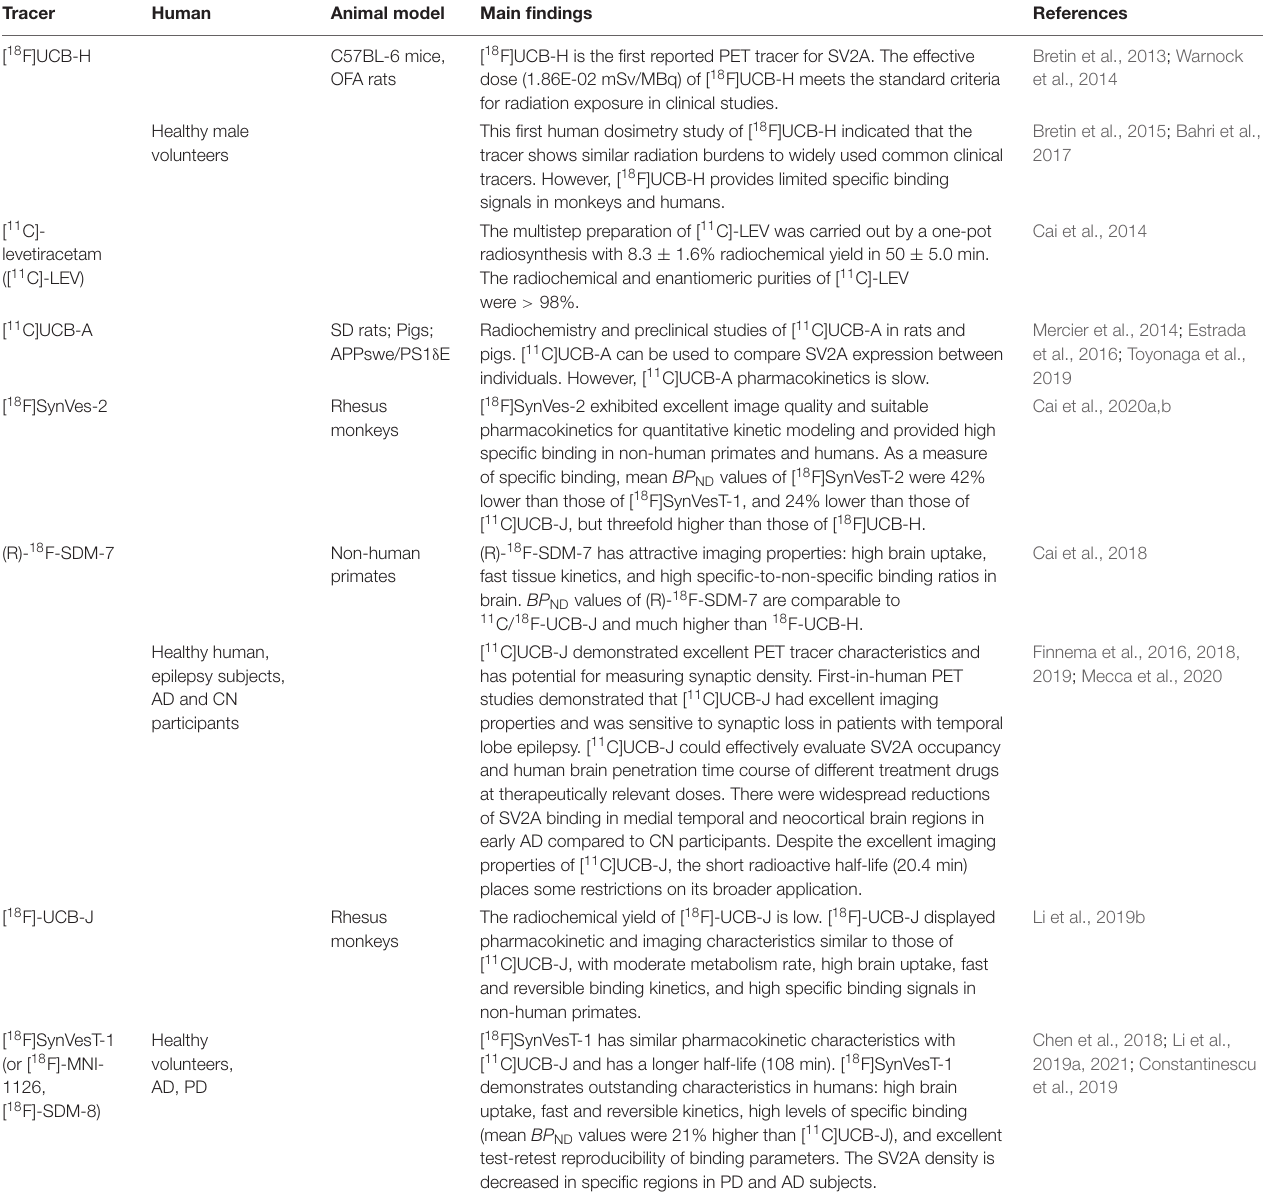
TABLE 1 | SV2A positron emission computed tomography (PET)